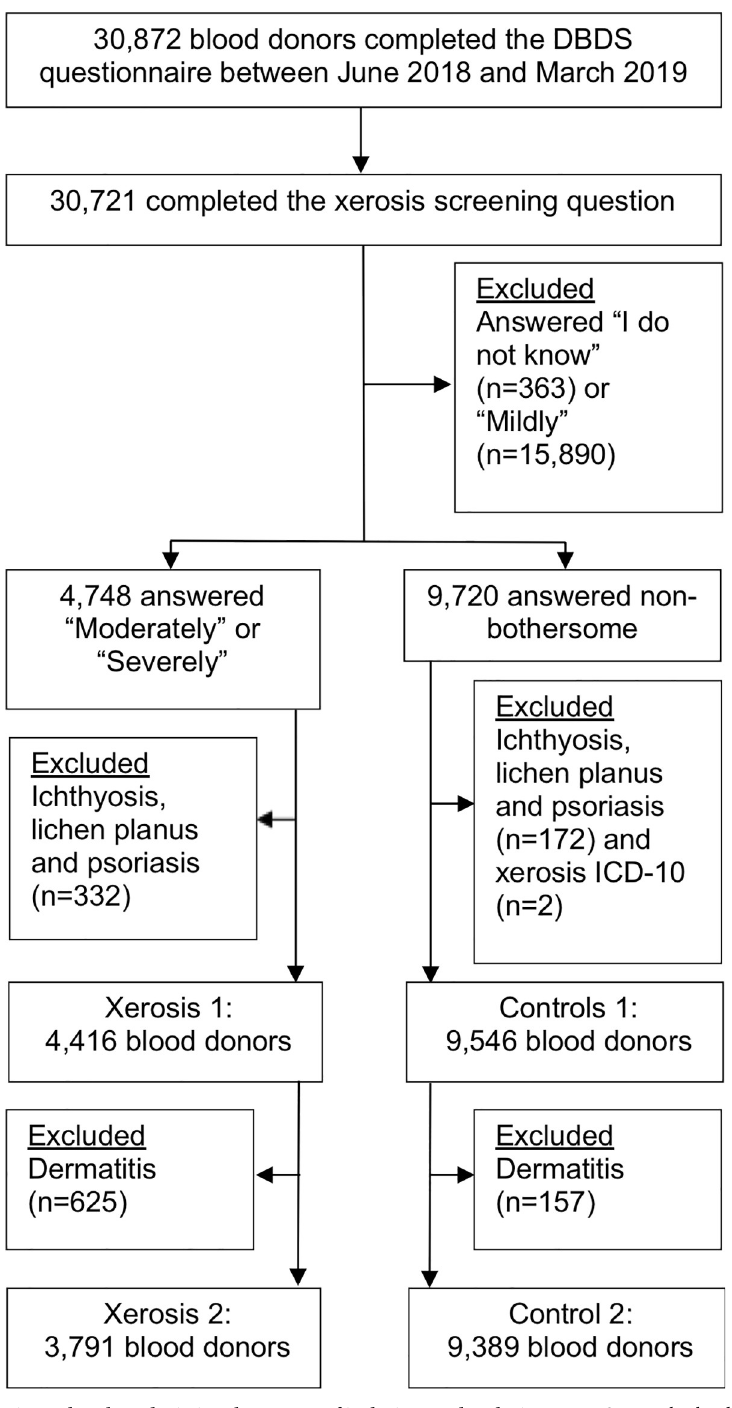
Fig 1. Flowchart depicting the process of inclusions and exclusions. DBDS, Danish Blood Donor Study; ICD-10, International Classification of Disease-10; n, Study population.